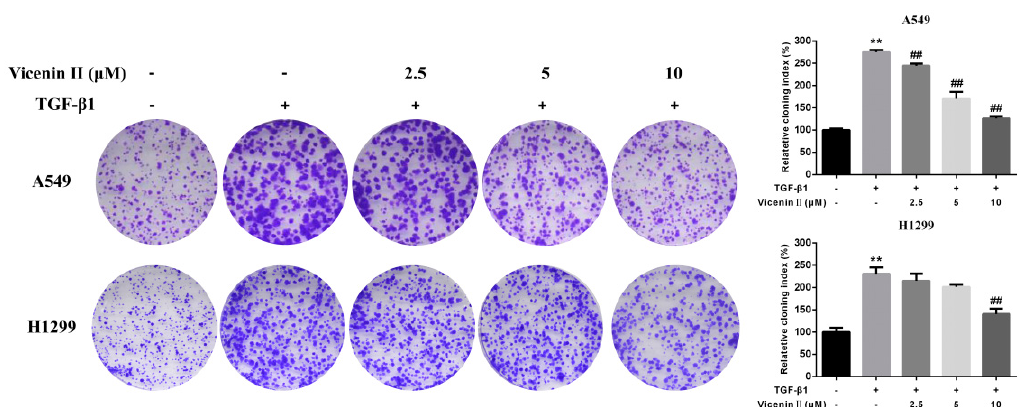
Figure 3. Effects of Vicenin Ⅱ on colony formation in human lung A549 and H1299 cells. After being co ‐ incubated with 5 ng/mL of TGF ‐β 1 and Vicenin Ⅱ (2.5, 5 and 10 μ M) for 14 days, the clonogenic potential of each group was analyzed by colony formation assay. Representative graphs and a histogram (mean ± SD) are shown, n = 3. ** p < 0.01 compared with the control group; ## p < 0.01 compared with the TGF ‐β 1 group.